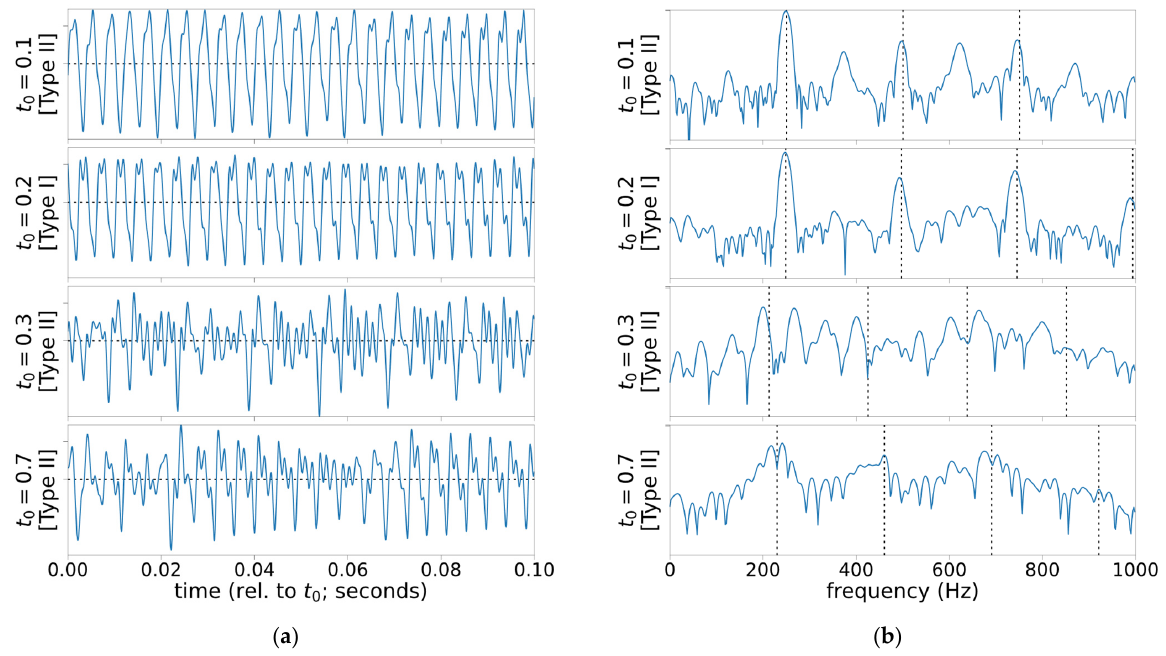
Figure 1. Snapshots of acoustic signal with mid-phonation bifurcation. At t 0 = 0.2, the voice mostly presents Type-I behavior. It is, however, preceded by a Type-II mode with substantial subharmonics at t 0 = 0.1 and is then followed by Type-II voice with strong biphonia at t 0 = 0.3. Another mode of biphonia occurs later at t 0 = 0.7: ( a ) time-domain plots each over 100-ms window; ( b ) normalized power spectral density estimates (periodogram with Hamming window; only showing below 1 kHz, range − 50 to 0 dB) in decibel scale. Vertical dotted lines indicate the estimated harmonic frequencies by Praat’s pitch estimator